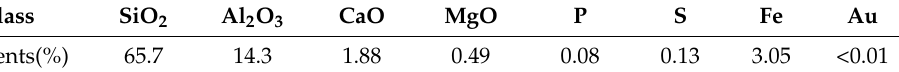
Table 1. Chemical composition of tailings.